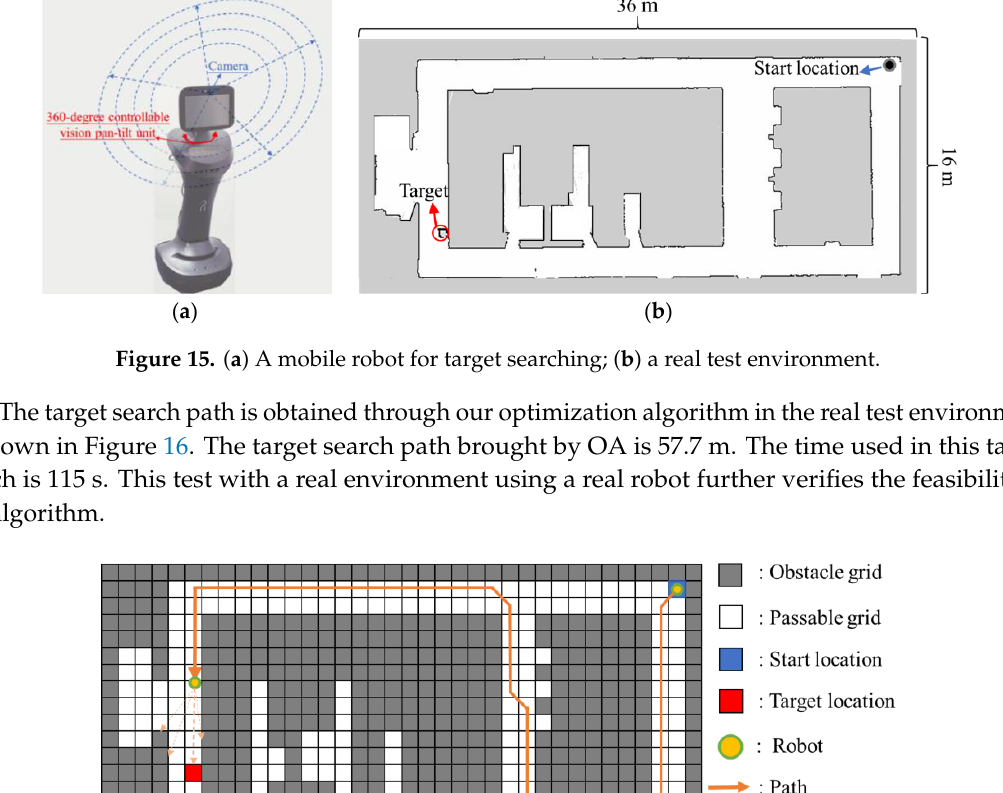
Figure 14. The distance reduction rate of path obtained by OA relative to RBA and GA.